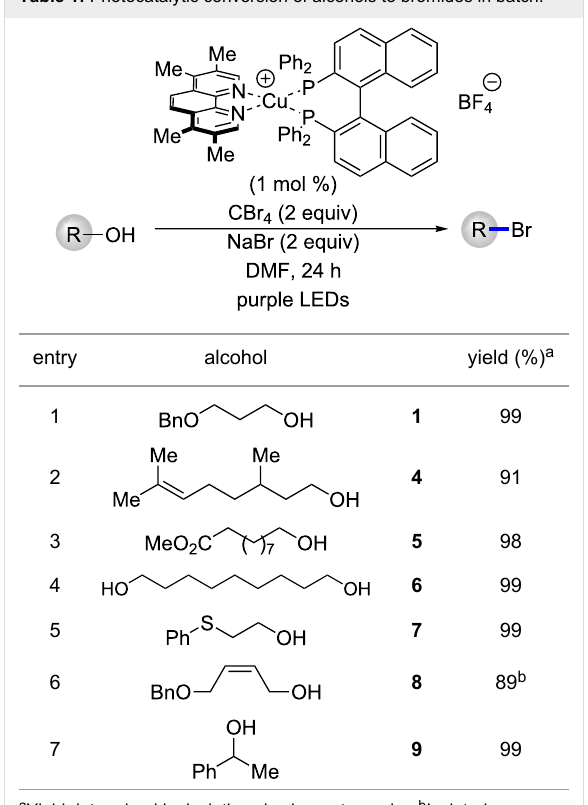
Table 1: Photocatalytic conversion of alcohols to bromides in